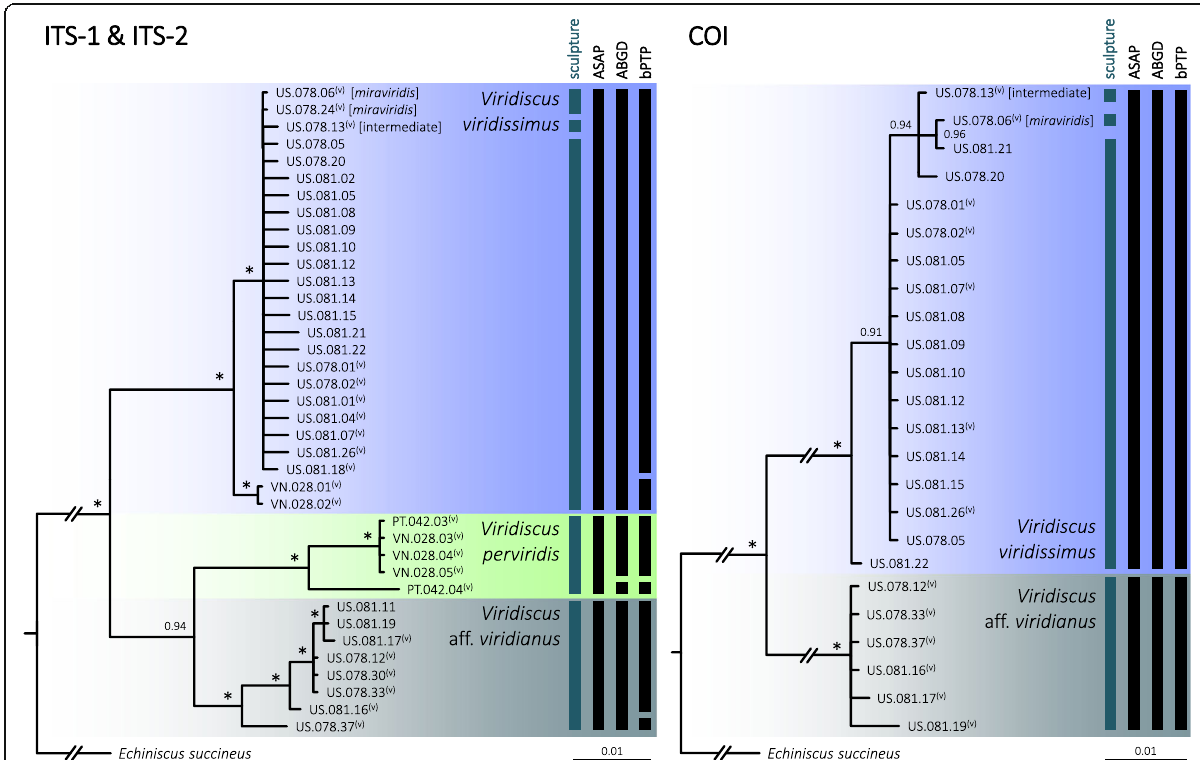
Fig. 3 Phylogenetic relationships of the genus Viridiscus : left panel: Bayesian tree based on the concatenated ITS-1 + ITS-2 dataset (1064 bp); vertical bars denote different delineation methods used in the formulation of the primary species hypotheses: sculpture (dorsal plate sculpture observed in PCM), ASAP, ABGD, and bPTP; right panel: Bayesian tree based on COI (611 bp). Asterisks indicate the maximal (1.00) posterior probability value; (v) – a hologenophore was secured for post hoc PCM analysis [the miraviridis morphotype and an intermediate morphotype between viridissimus and miraviridis are indicated in square brackets]. Echiniscus succineus was used as an